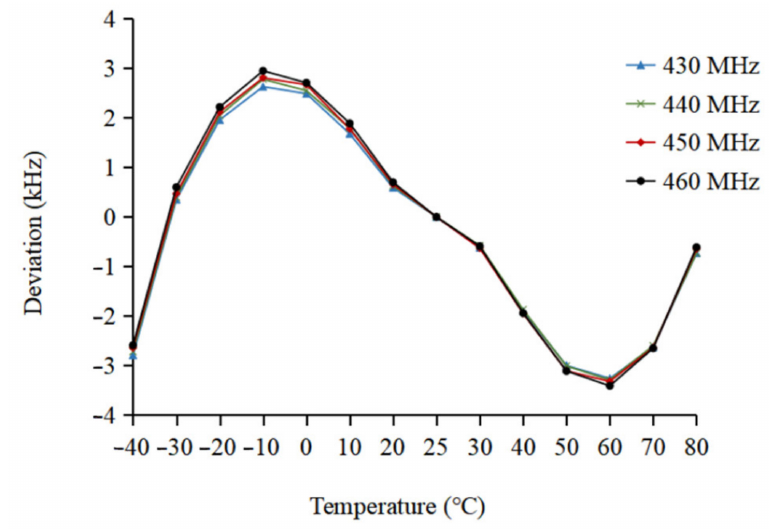
Figure 11. The temperature drifts under different temperatures.